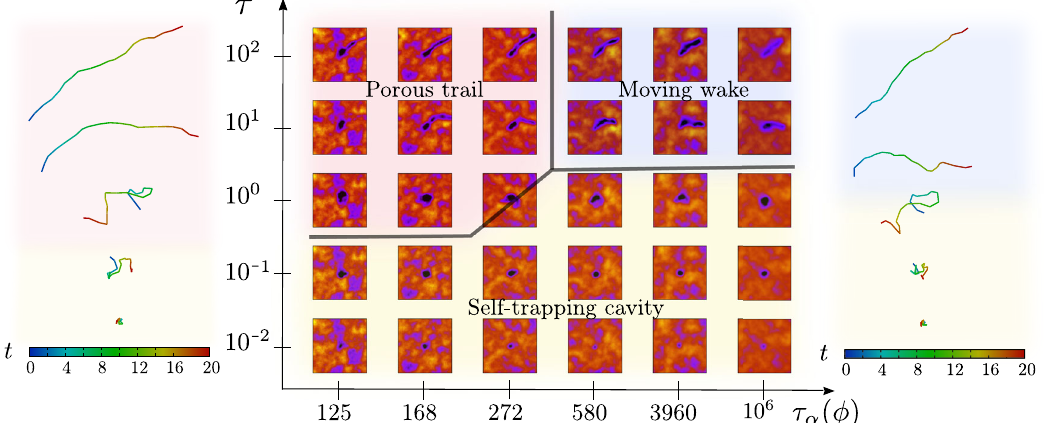
Fig.3|Remodellingofthecompressiblemediumbytheactiveparticles. Under- denseregionsinthecompressiblemedium(darkerbluecoloursindicatelow ρ ,and the yellowcoloursindicate a high ρ where ρ isthe localdensity) thatisremodelled bythemotileparticles,asafunctionofthepersistencetime τ anddensityrelaxation time τ α ( ϕ ), for fi xed (large) f . The geometry of the under-dense regions goes from being a static cavity to a moving wake around the motile particle, to a long-lived